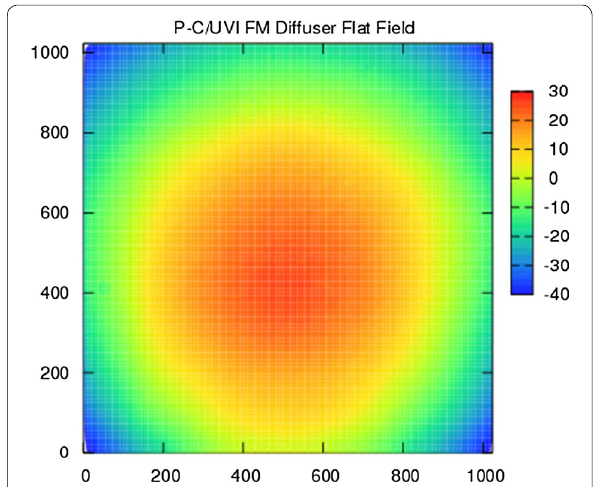
Fig. 5 Raw flat image of the integrating sphere using the diffuser with no